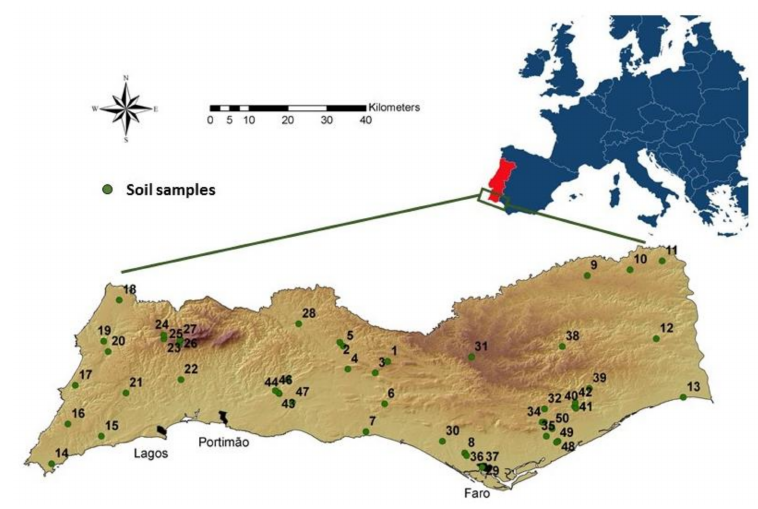
Figure 1. Distribution of the sampling sites along the Algarve region, Southern Portugal (see Campos-Herrera et al. [46] for additional